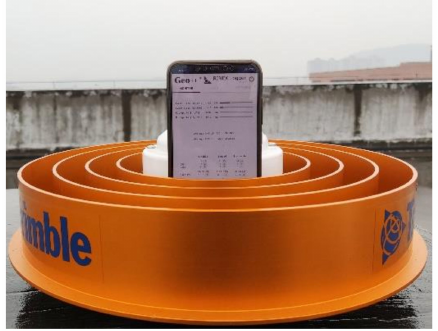
Figure 16. Experiments using choke coil to suppress multipath interference.